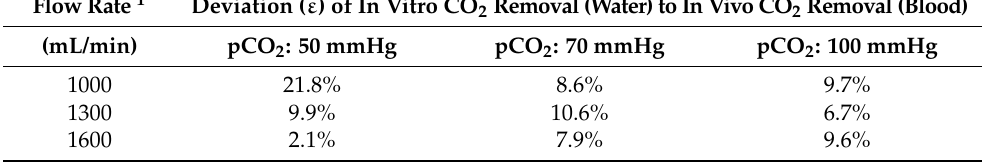
Table 5. Deviation of the in vitro CO 2 removal with water to the in vivo CO 2 removal with blood ( ε